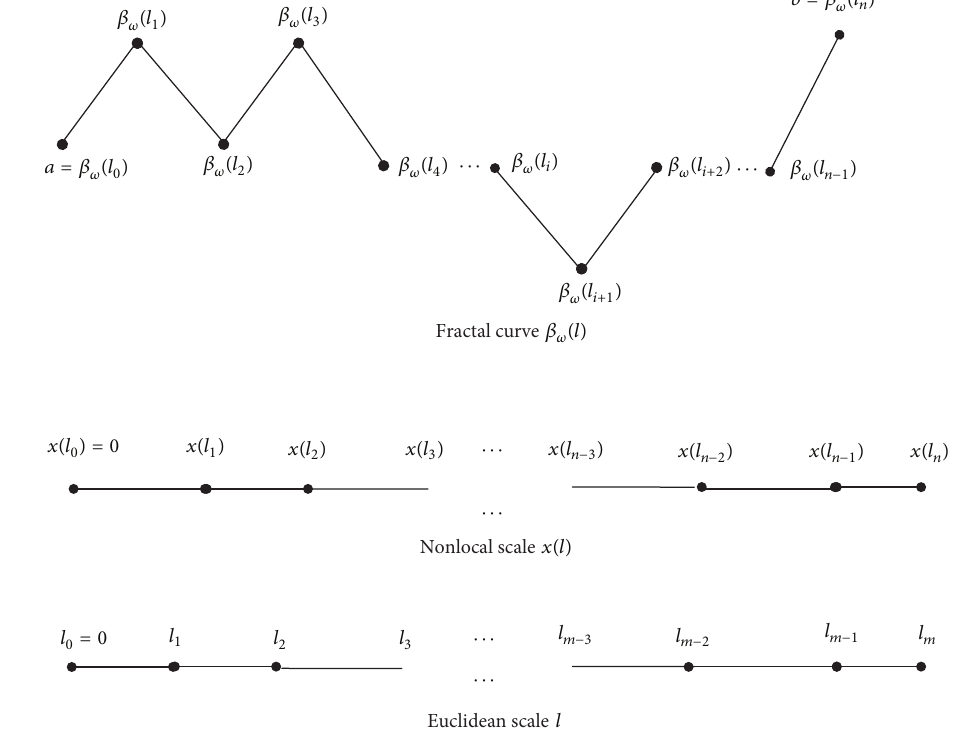
(𝑙 ) and 𝛽 (𝑙 ) cannot be measured using the 𝜔 0 𝜔 𝑛